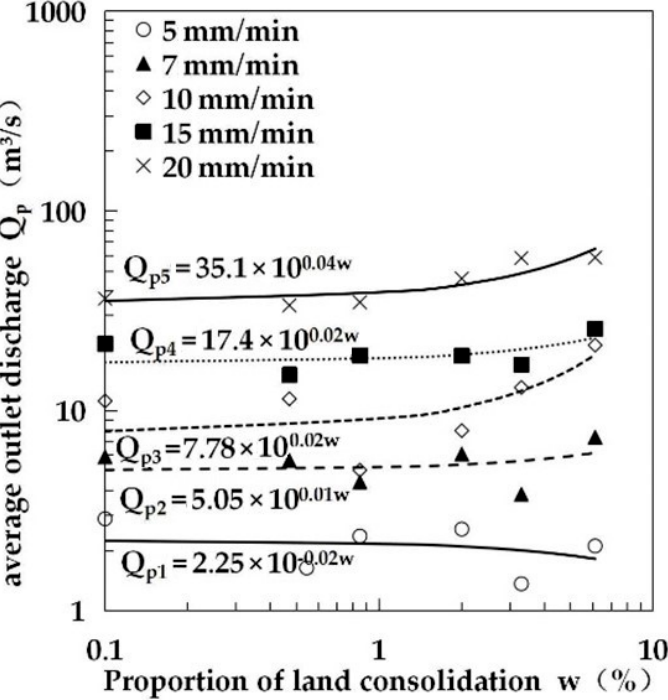
Figure 23. Changes in average outlet discharge with land consolidation proportion under different rainfall intensities.